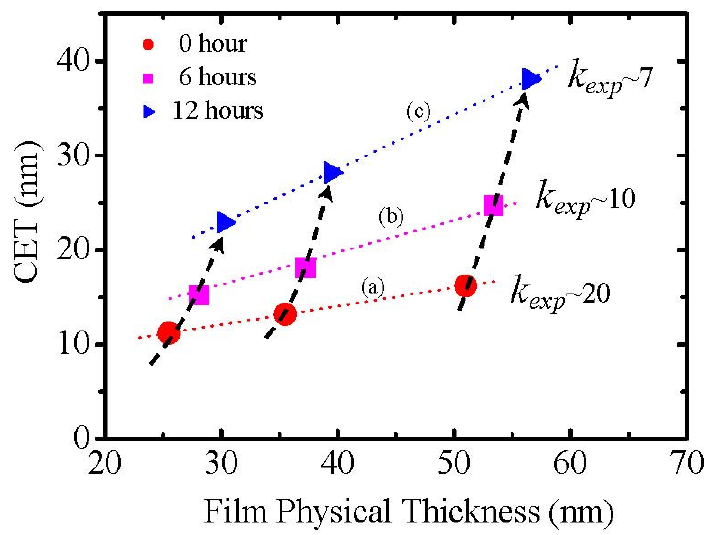
Figure 3. The relationship of CET to La capacitors. The sample was exposed to air for: ( a ) zero hours; ( b ) 6 hours and ( c ) 12 hours before SiO layer 2